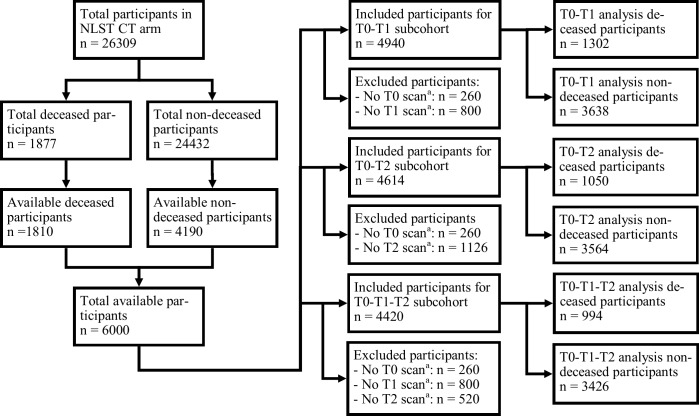
Participant selection flow chart.NLST, National Lung Screening Trial; T0, baseline screening round; T1, first annual follow-up screening round; T2, second annual follow-up screening round. a CT images may be missing due to the participant skipping a screening round, corrupted images, or incomplete images. Each subsequent exclusion count does not overlap with the previous criteria.